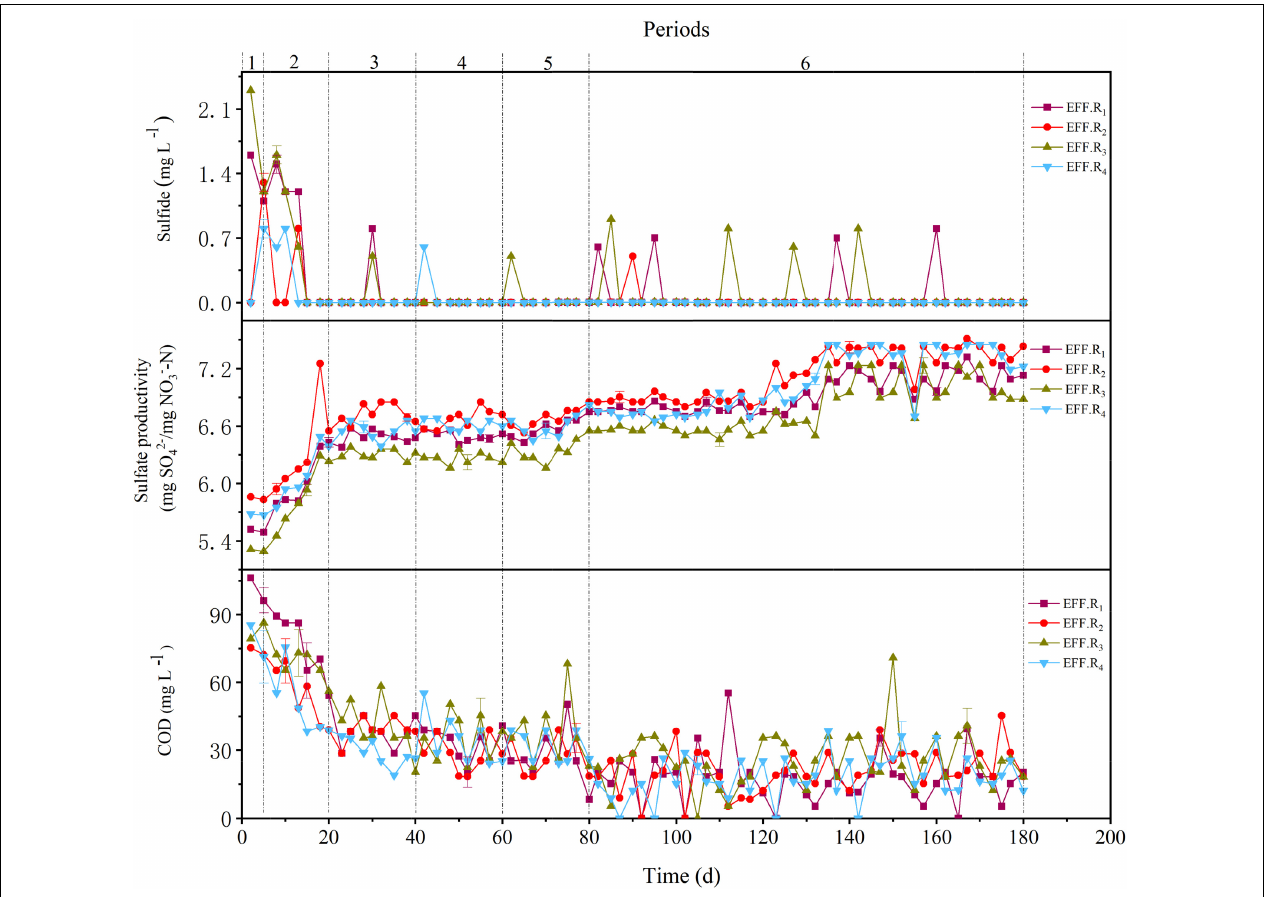
FIGURE 2 | Variations in sulfide, COD, and sulfate productivity in periods 1–6 of the R 1 –R 4